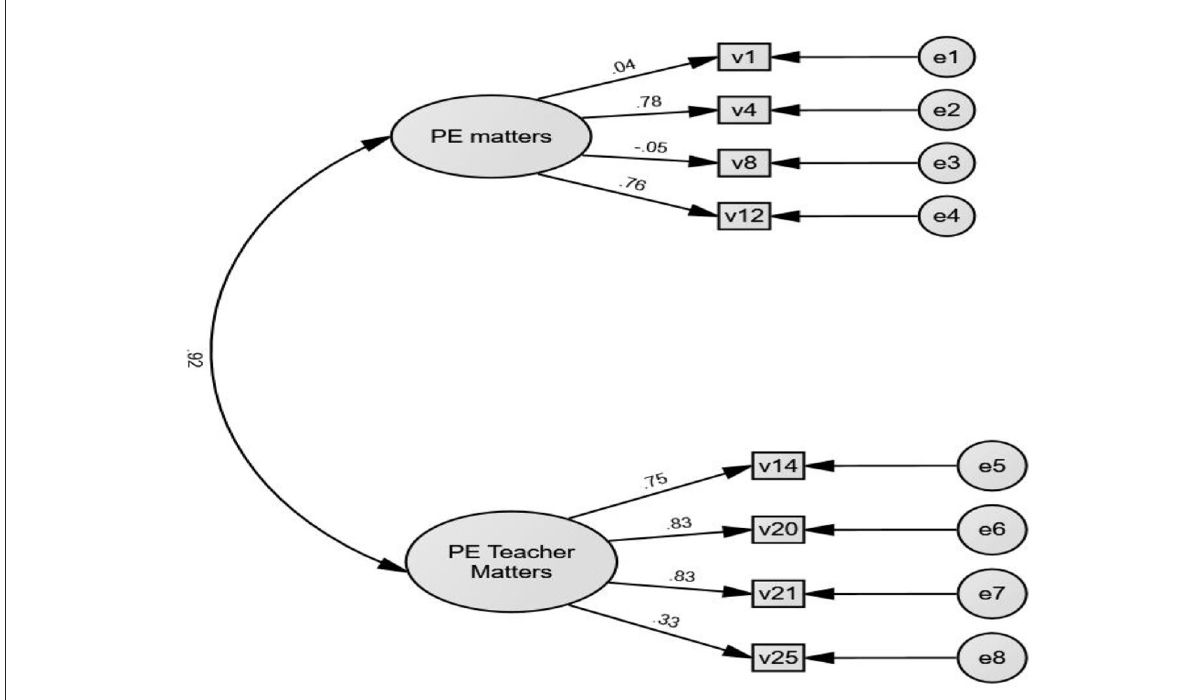
FIGURE1 Two factors with eight items for